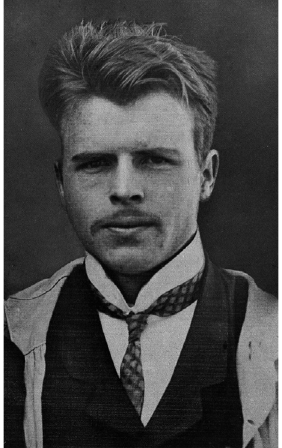
Figure 1. Hermann Rorschach – International Dictionary